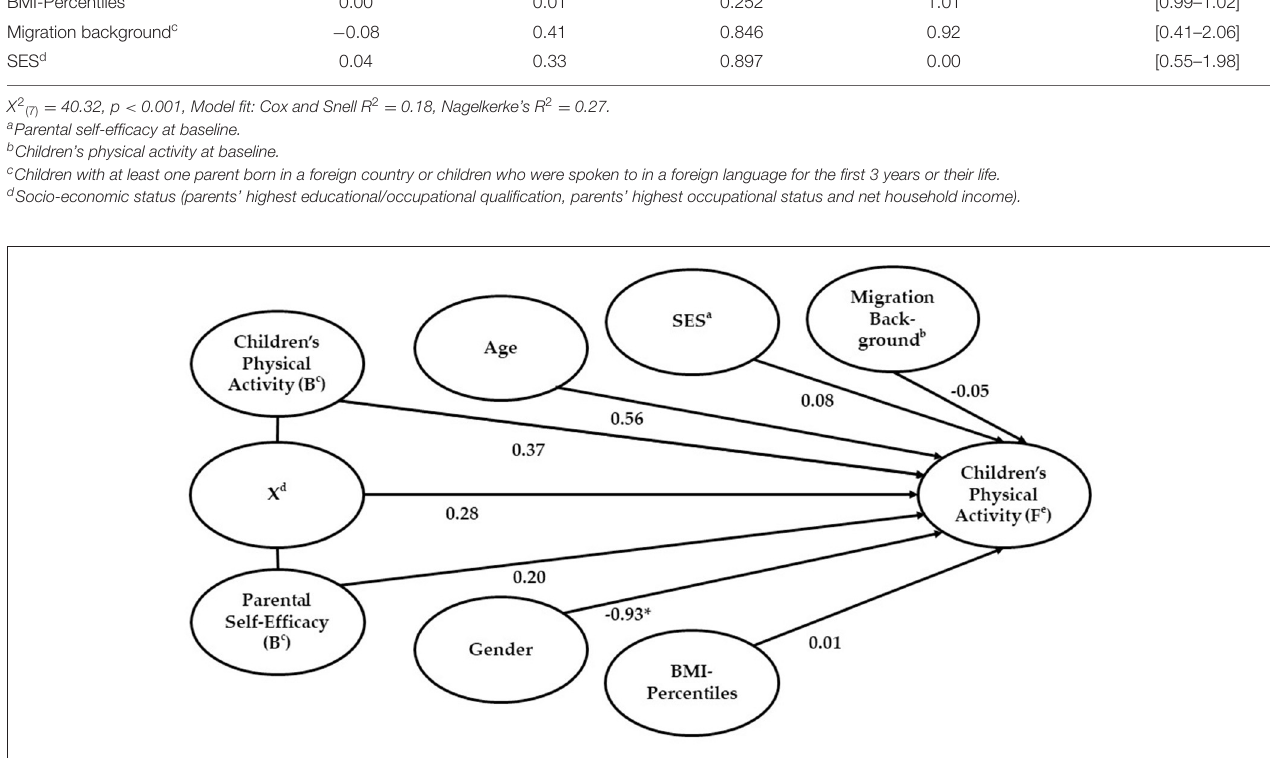
FIGURE 1 | Parental self-efficacy at baseline as predictor of the intervention effect on children’s physical activity. Results of the final model with all predictors (203 cases included [ X 2 (8) = 41.17, p < 0.001, Model fit: Cox and Snell R 2 = 0.18, Nagelkerke’s R 2 = 0.28). Statistics are standardized regression coefficients. Lines represent relations. * p < 0.05. a Socio-economic status (parents’ highest educational/occupational qualification, parents’ highest occupational status and net household income). b Children with at least one parent born in a foreign country or children who were spoken to in a foreign language for the first 3 years or their life. c B, baseline. d X, interaction effect. e F,